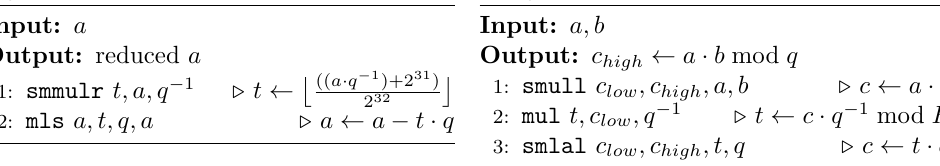
Algorithm 7 Signed Barrett reduction us- ing β = 2 32 .